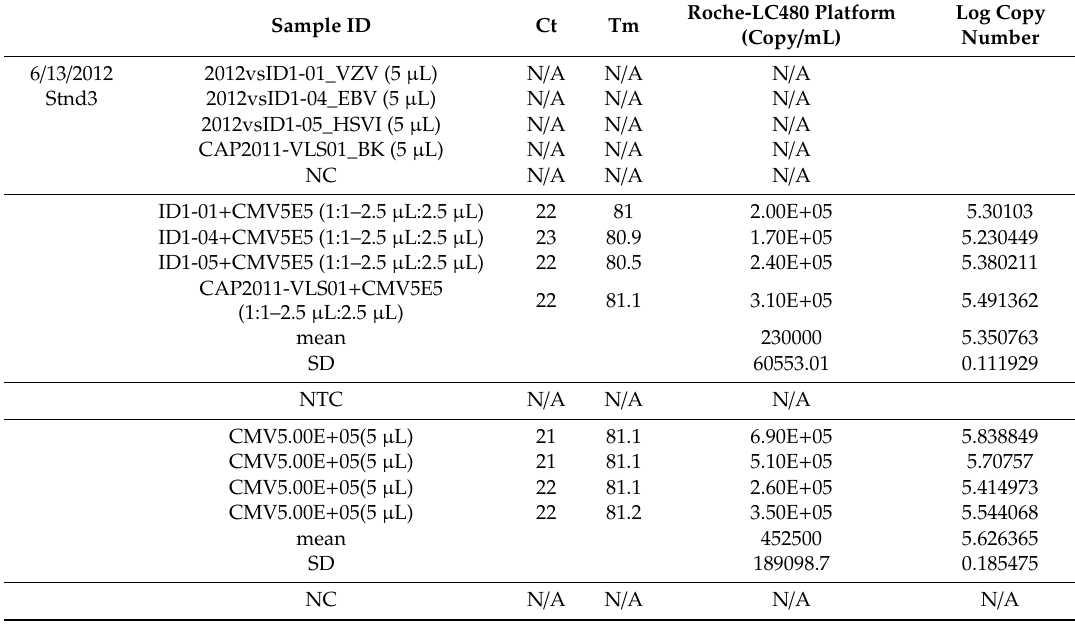
Table 4. Analytical specificity as determined by the interference study of cytomegalovirus (CMV) with BK virus, Epstein–Barr virus (EBV), herpes simplex virus type I (HSVI), and varicella-zoster virus (VZV). N / A—not applicable; NC—normal control; NTC—no template control. Sample ID Ct